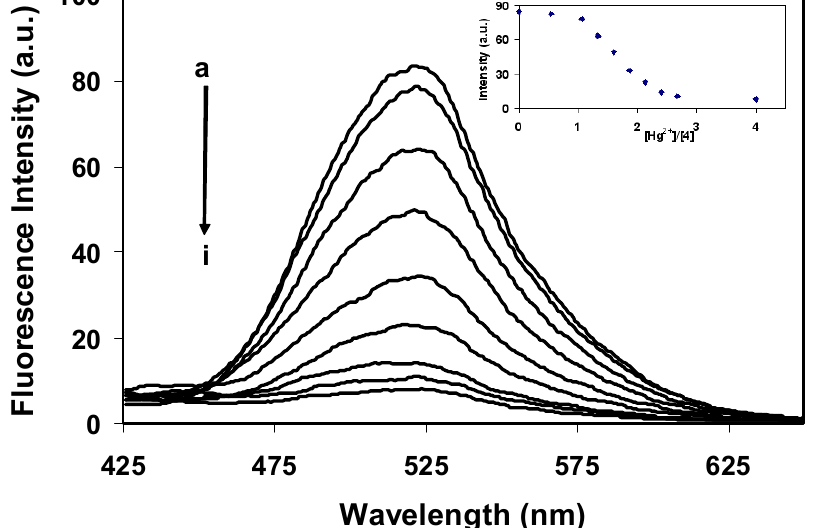
Figure 4. Fluorescence emission spectra ( λ CN:H O as function of [Hg 2+ ]. a: 0 M, b: 0.27 μ M, c: 0.33 μ M, d: 0.40 μ M, e: 0.47 CH 3 2 μ M, f: 0.53 μ M, g: 0.60 μ M, h: 0.67 μ M, i: 1.00 μ